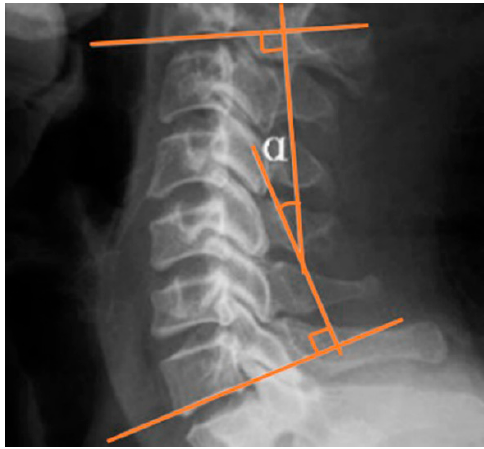
Figure 2. Cobb angle of cervical lordotic curve.